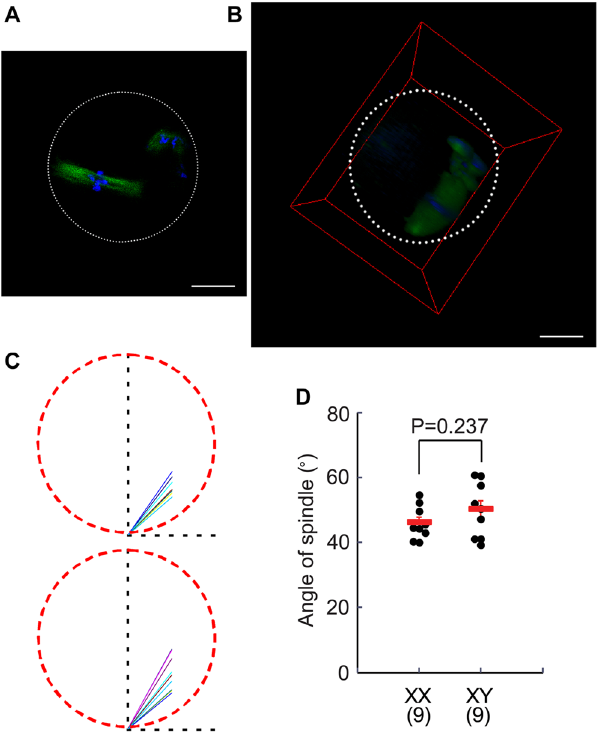
Figure 3. Normal orientation of MII-spindles in the IVM-oocytes from XY females. ( A ) 2D-image of a single z-section. An MII-oocyte from an XY female stained with anti- α -tubulin antibody (green) and DAPI (blue). The white broken circle indicates the position of zona pellucida. Bar: 20 µ m. ( B ) 3D-image reconstructed from more than 40 z-sections at every 2.0 μ m. The red box indicates the boundaries of 3D-image. The white broken circle indicates the position of zona pellucida. Bar: 20 µ m. (The video of the 3D-image is given in Supplementary Fig. S1) ( C ) Summary of spindle orientation in the oocytes from XX and XY females. The red broken circle in each picture indicates the position of zona pellucida. The vertical axis was drawn to go through the center of each oocyte and the farther pole of the spindle. The spindle orientations in individual oocytes are shown in different colors. The angle of the spindle axis was measured from the horizontal axis in each oocyte. ( D ) Summery of spindle angles measured in the oocytes from XX and XY females. No difference is found between the two genotypes. Data are presented as means ± SEM. The total number of oocytes examined was given in parentheses at the